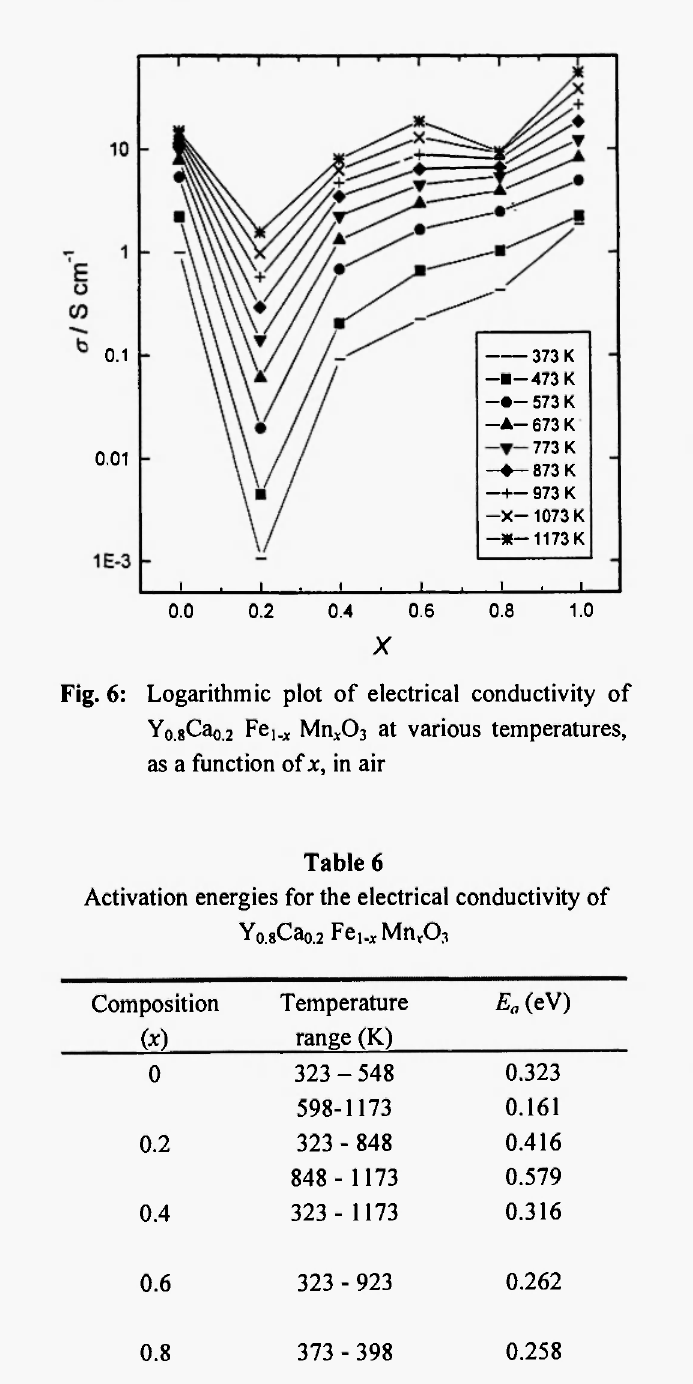
Fig. 6: Logarithmic plot of electrical conductivity of Yo.gCao.2 Fe,. x Mn x 0 3 at various temperatures, as a function of x, in